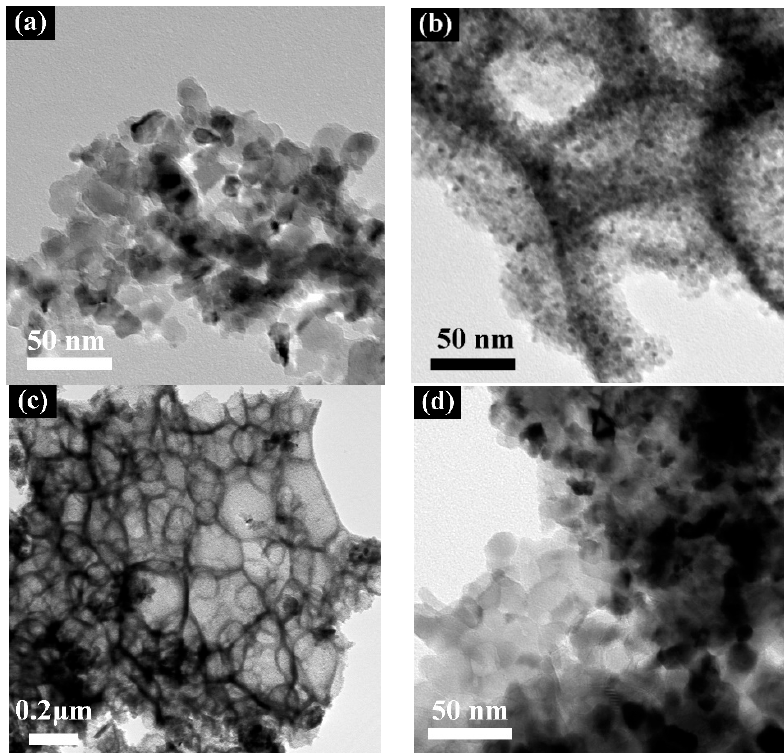
Figure 3. Sample S27. TEM bright field images of areas exhibiting 20–40 nm crystallites ( a ). Sample 27 (75 mL H 2 O) and 5–12 nm crystallites ( b ). ( c ) A low-magnification TEM image of area ( b ). TEM bright field image of sample S25 (50 mL H 2 O) ( d ).